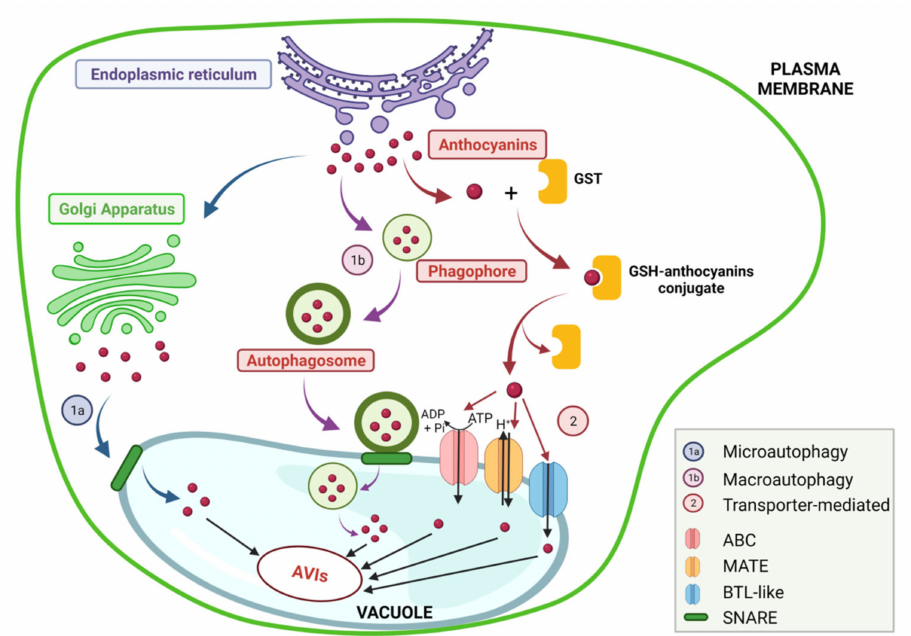
Figure 3. Illustration of the transportation routes of ANs post-biosynthesis, from the endoplasmic reticulum (ER) to the vacuoles. ANs travel from their synthesis location to the vacuole, for storage. The first two ways, micro- (1a) and macro-autophagy (1b), involve ER-derived vesicles, which facilitate the transit of anthocyanins to the tonoplast where they attach to the membrane through soluble N -ethylmaleimide-sensitive factor attachment protein receptors (SNARE) and release the ANs inside. The other transportation method is membrane transporter-mediated pathway (2) which involves several membrane proteins (MATE, ABC, and BTL-like transporters) that facilitate the transportation of ANs inside the vacuoles and their sequestration in vacuolar inclusions (AVIs). In this case, ANs are not transported in vesicles but are conjugated by GSTs (glutathione S -transferases) and form together the GSH (glutathione)—ANs conjugate, a stable and efficient form of transportation from ER to the tonoplast (original